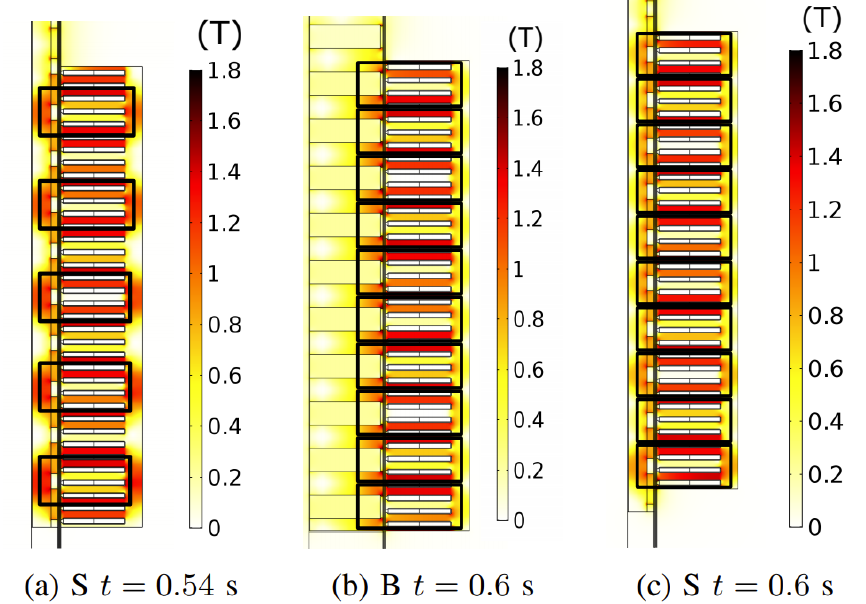
Figure 5. surface-mounted (S) and buried (B) topologies at different time